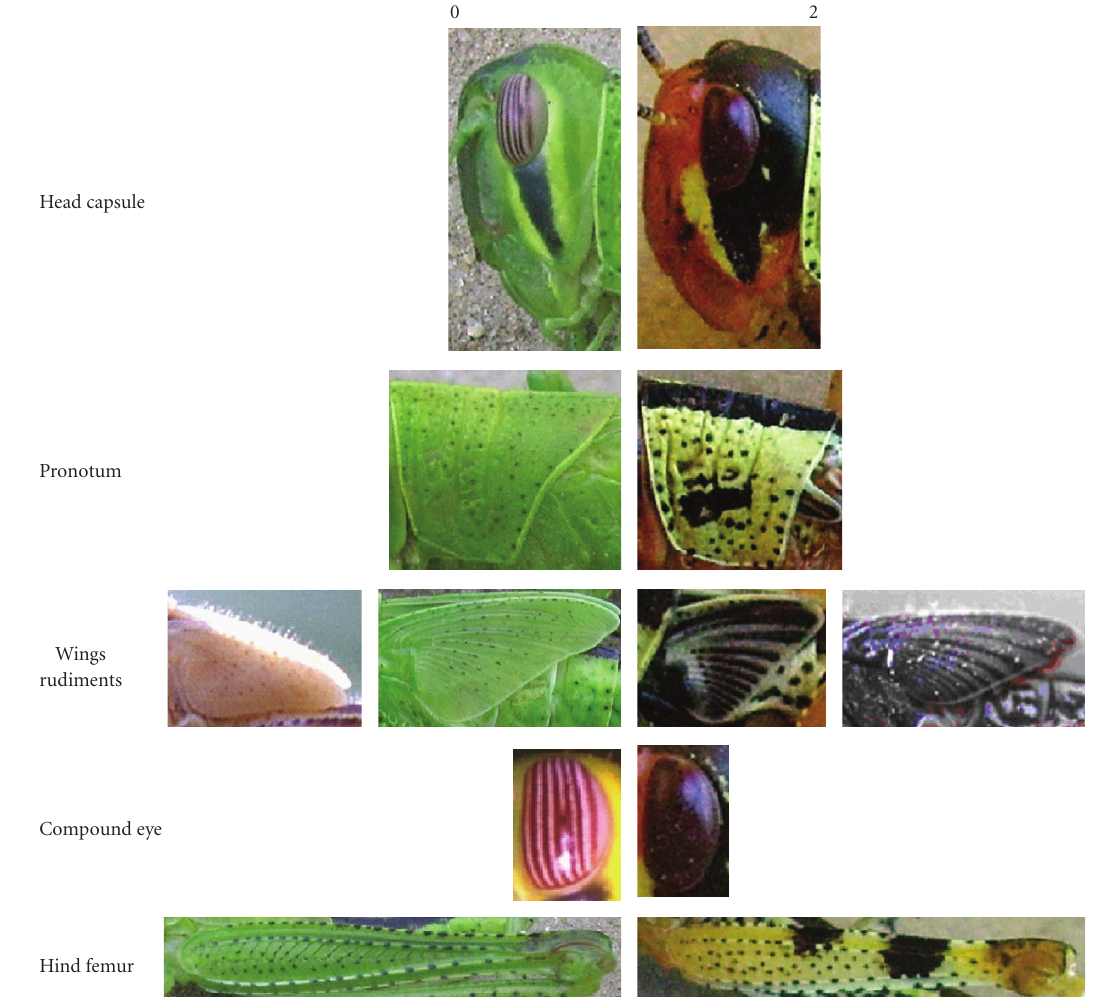
Figure 1: Color patterns and morphological variables selected to characterize the pigmentation of Red Locust hoppers. Note that the subocular stripe is a constant characteristic of the Red Locust but, in case of gregarisation, it tends to disappear under the general black pigmentation of the posterior part of the head. Photos: M. Lecoq, A. Chamouine and M.H.